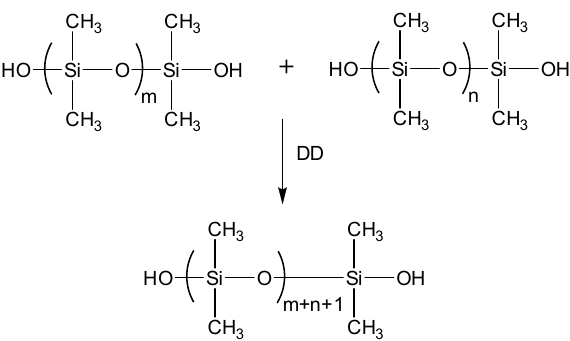
Scheme 1. Condensation reaction of silanol-terminated polydimethylsiloxane (STP) in the presence of dibutyltin dilaurate (DD).